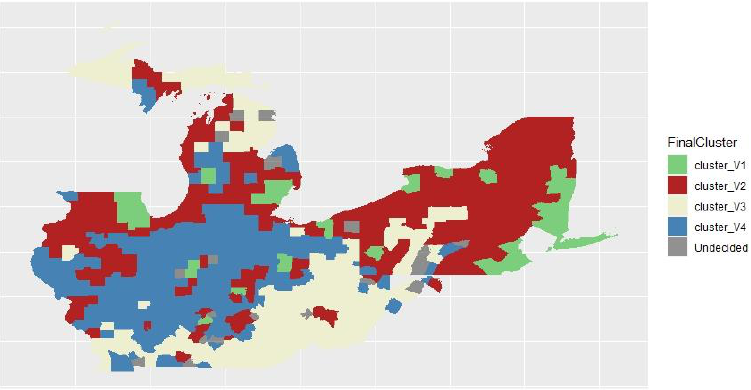
Figure 11. Final cluster of SGFCM.